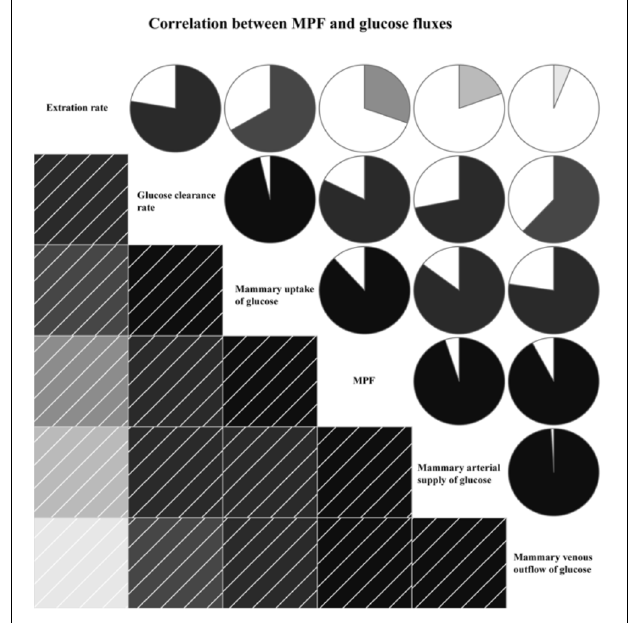
FIGURE 4 | Correlation between mammary plasma flow (MPF) and glucose fluxes. In left square matrix, the deeper color and the higher the saturation of the cells, the greater positive correlation of variables. Meanwhile, in right circle matrix, the filled pie charts from clockwise visualize the positive correlation of